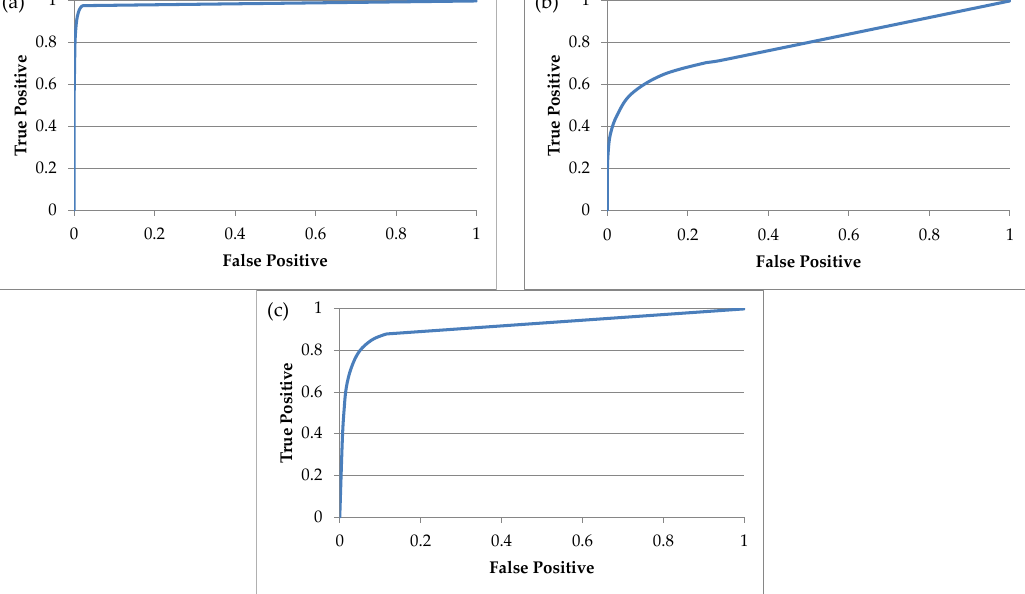
Figure 8. The ROC curves in case of 99 subjects for: ( a ) scenario (a) AUC = 0.987; ( b ) scenario (b) AUC = 0.789; ( c ) scenario (d) AUC = 0.921. AUC = Area Under Curve.